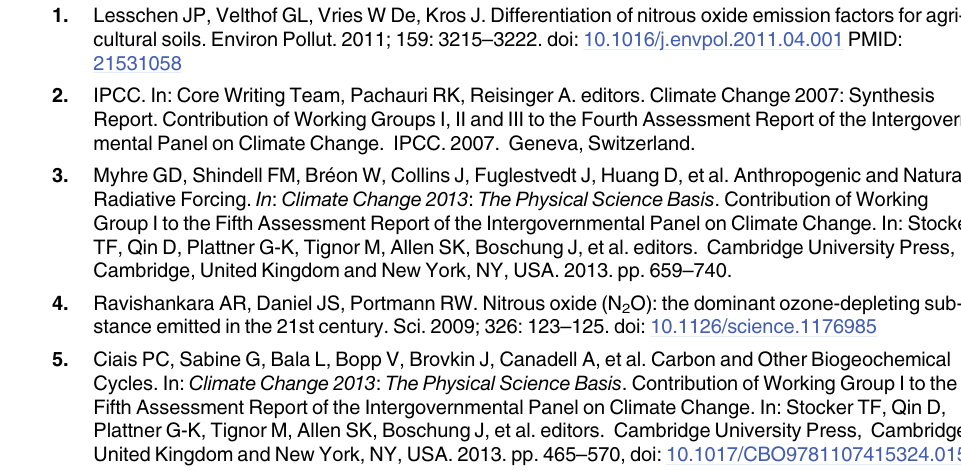
O production index ( I N O) and N O/(N O+N ) product ratio values S2 Fig. Maximum N 2 2 2 2 2 observed in all soils. Values represent the mean and standard error of triplicate flask results. S1 Table. Physical and chemical characteristics of soil samples. S2 Table. Soil pH measurements. Soil pH values as determined using three different extrac- and 2M tion methods (DI water, 0.01 M CaCl 2